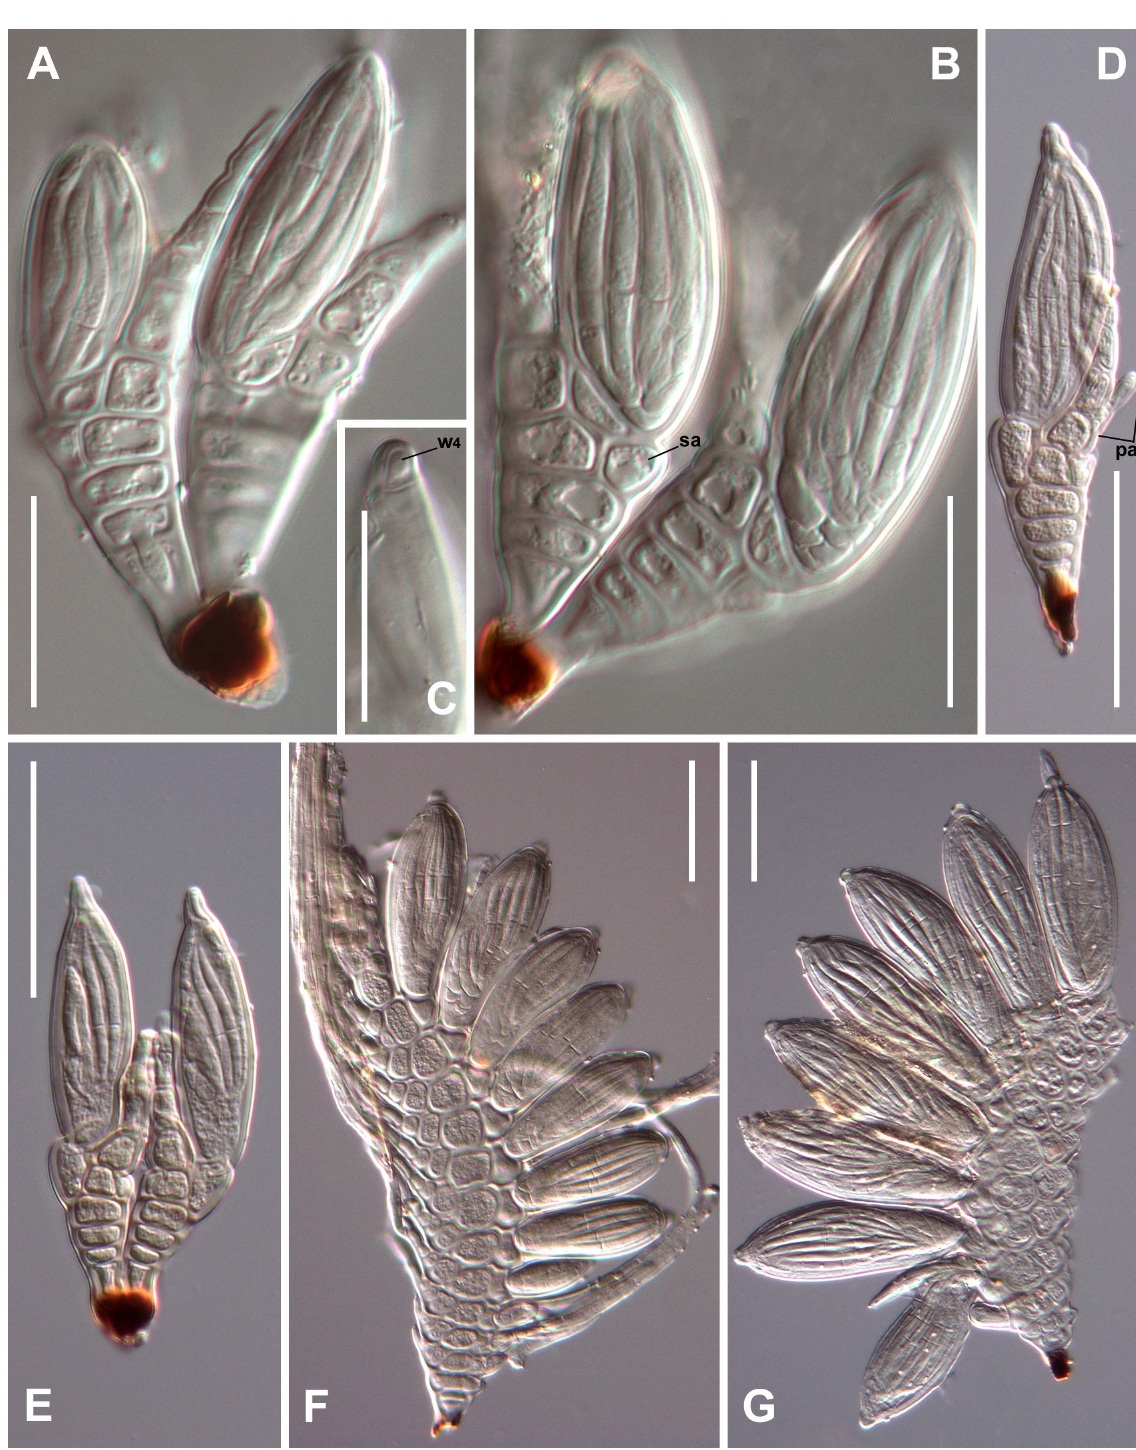
Fig. 9. Euphoriomyces spp. A – C . E. gillerforsii (Huggert) I.I.Tav. A – B . Paired mature thalli, with unicellular secondary appendage labelled in B (sa). C . Detail of perithecial apex with labelled extra cell w . – D – E . E. huggertii T.Majewski . D . Mature thallus with labelled primary appendage (pa). E . Paired 4 mature thalli. – F – G . E. liodivorus (Huggert) I.I.Tav. Mature thalli. Scale bars: A–C = 20 µm; D–G = 50 µm. Photographs from slides ZMUC C-F-124079 (A–C), ZMUC C-F-123294 (D–E), ZMUC C-F- 124158 (F), and ZMUC C-F-124138